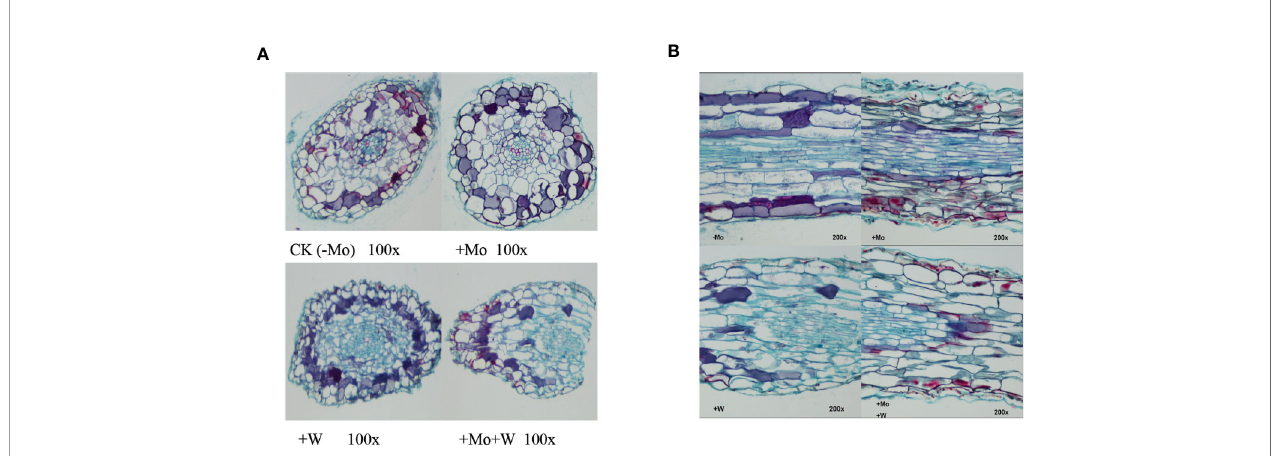
FIGURE 3 | Effect of solid MS culture medium with Na 2 MoO 4 or Na 2 WO 4 on the microstructure of cross-section of strawberry seedling roots (A) and on the microstructure of longitudinal section of strawberry seedling roots (B) .